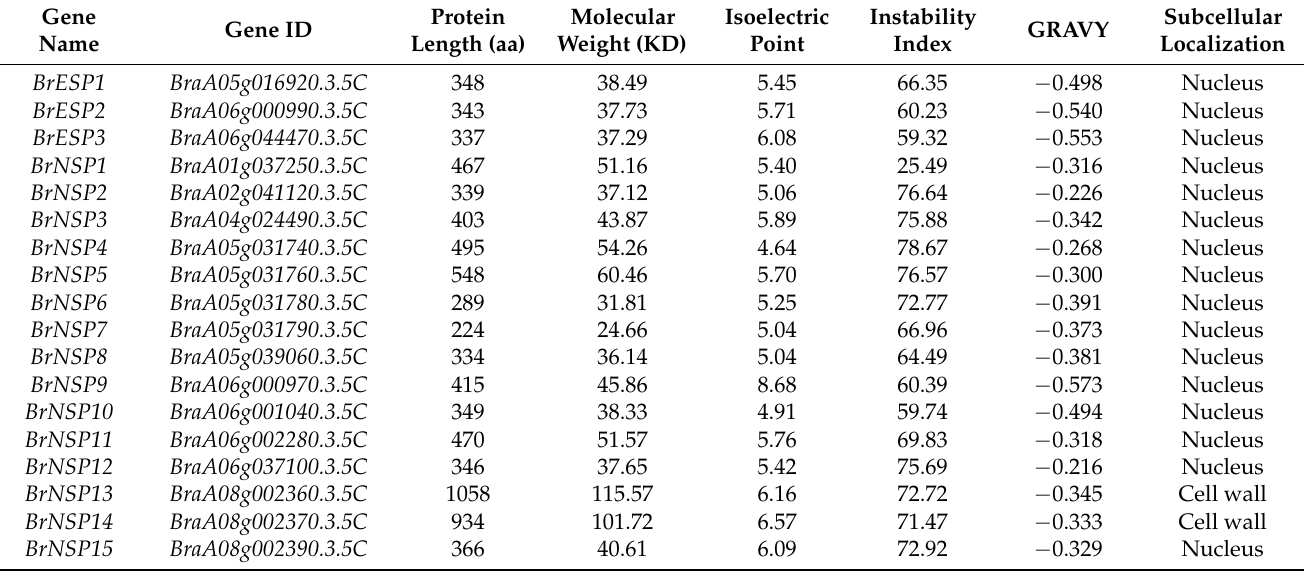
Table 1. Physiological and biochemical characterization of ESP and NSP proteins in Chinese